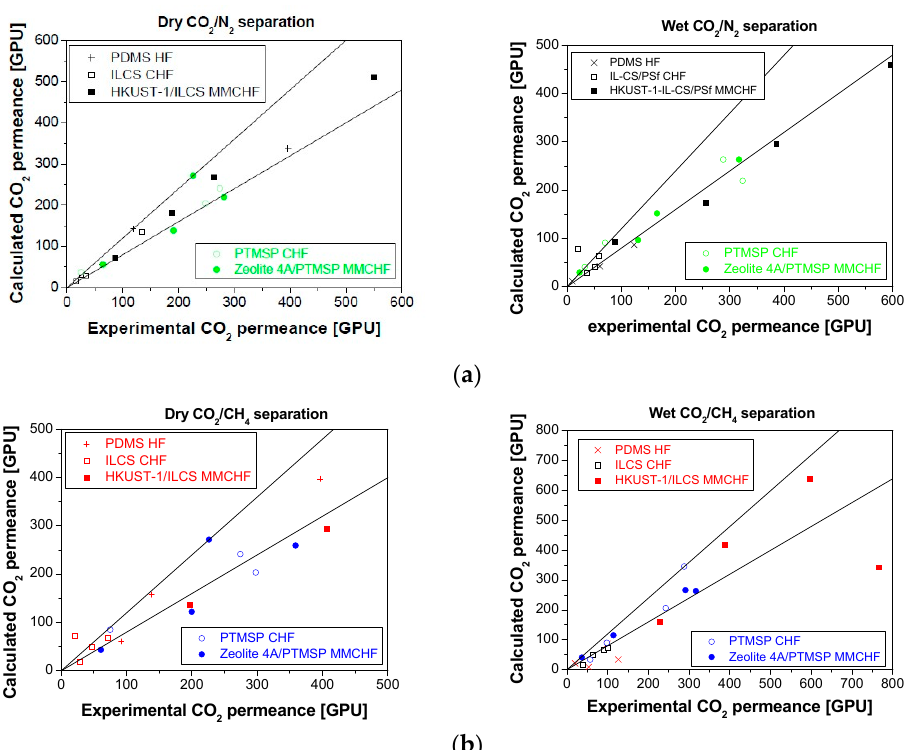
Figure 8. Parity plots for the CO 2 permeance in dry (left) and humid conditions (right) obtained for the CO 2 /N 2 ( a ) and CO 2 /CH 4 ( b ) separation for all membranes tested in this work.